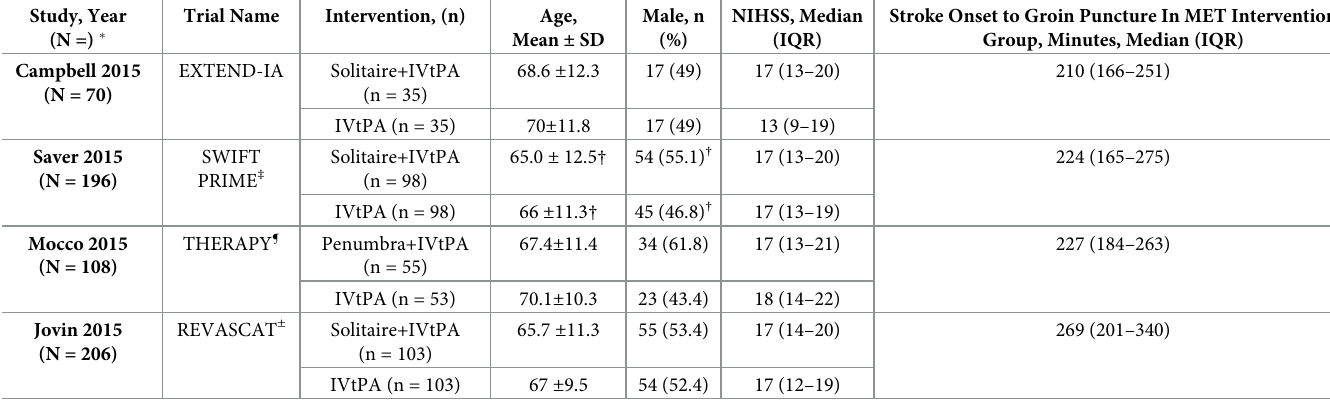
Table 1. Baseline characteristics of patients in included randomized controlled trials.